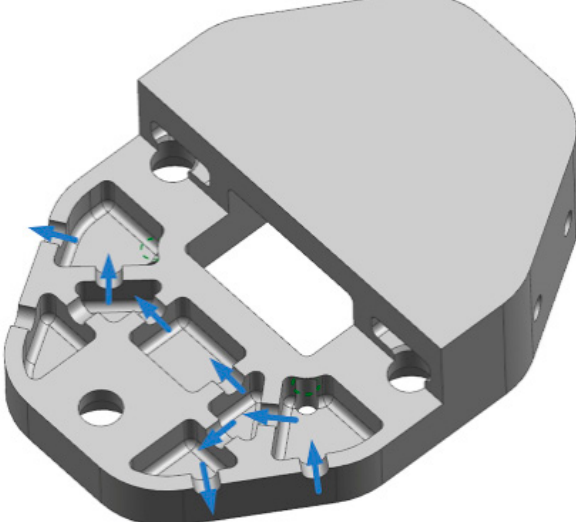
Figure 12. Schematic diagram of connectivity constraints [37].